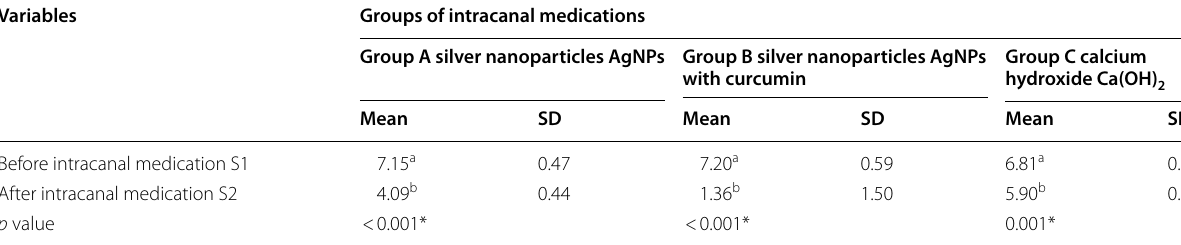
Means with different l letters in the same column indicate statistically significance difference * Significant ( p < 0.05)